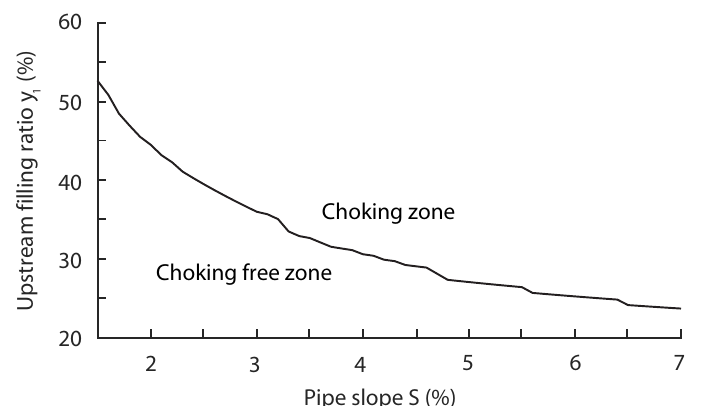
Figure 11. Limit to the initial filling ratio y 1 for choking-free flow after direct hydraulic jumps. The pipe diameter is D = 600 mm . Manning‘s roughness coefficient is n = 0.013.